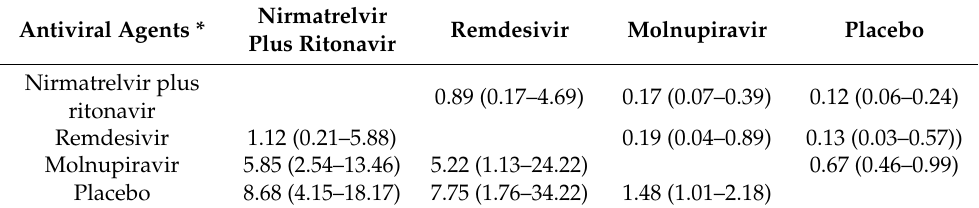
Figure 6. Forest plot of the network meta-analysis for COVID-19-related hospitalization or death from any cause. Table 2. Results of the pairwise comparisons in the network meta-analysis between antiviral agents for